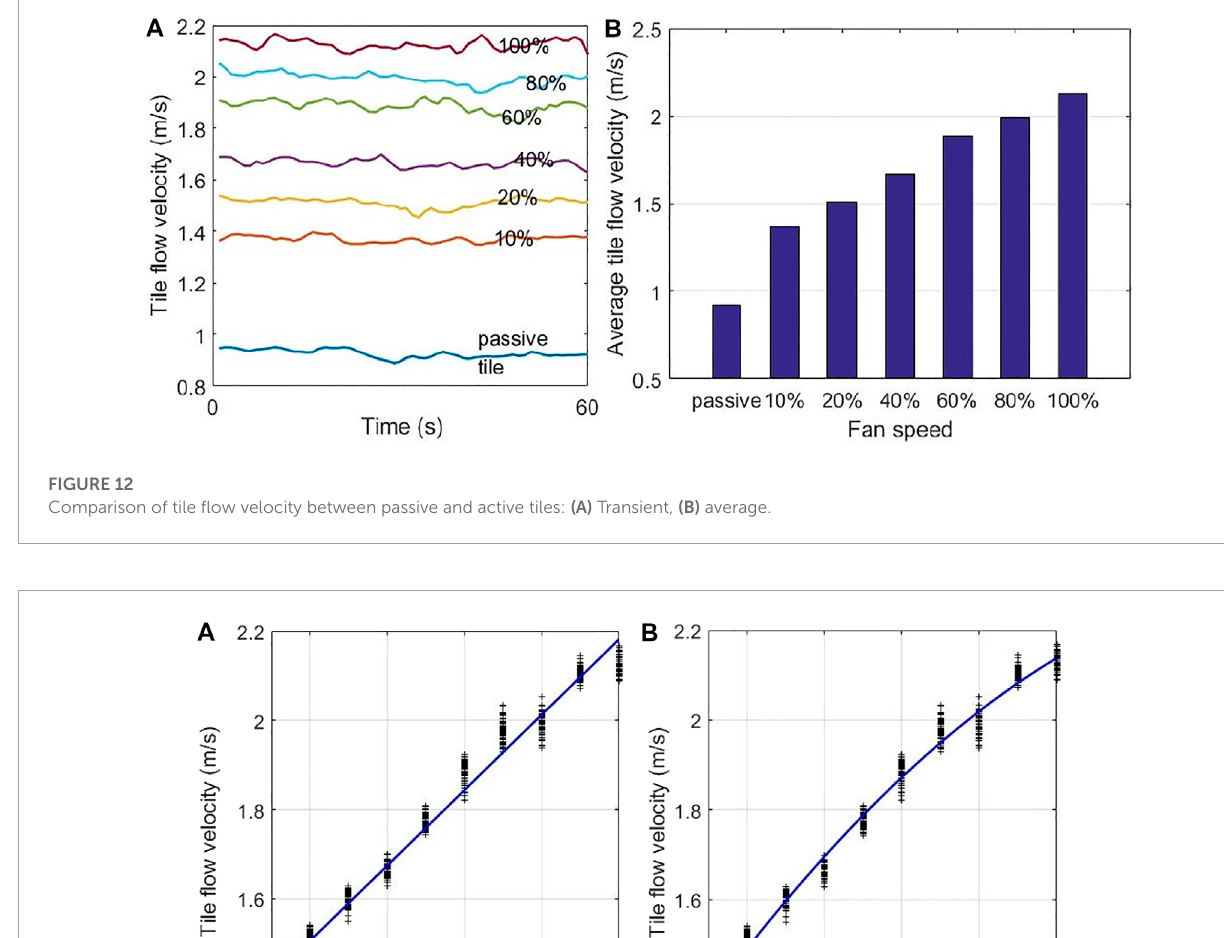
that for the unpowered active tile (around 0.95 m/s vs . 0.45